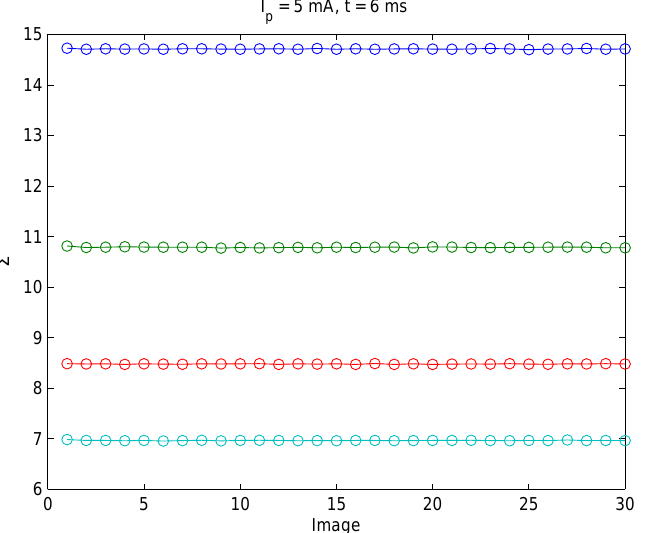
Figure 3. Consistency of the (cid:6) parameter extracted from the IRED images. The maximum dispersion over the 30 images was lower than a 0.5% of the mean value for each considered